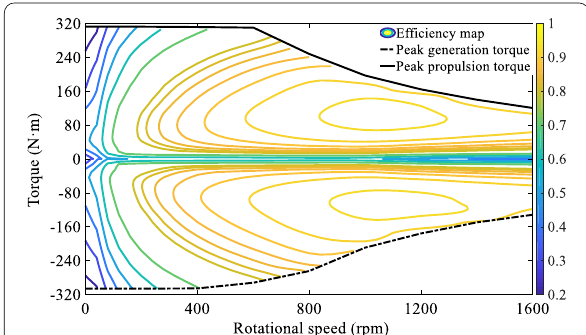
Figure 1 The efficiency map and peak torque of